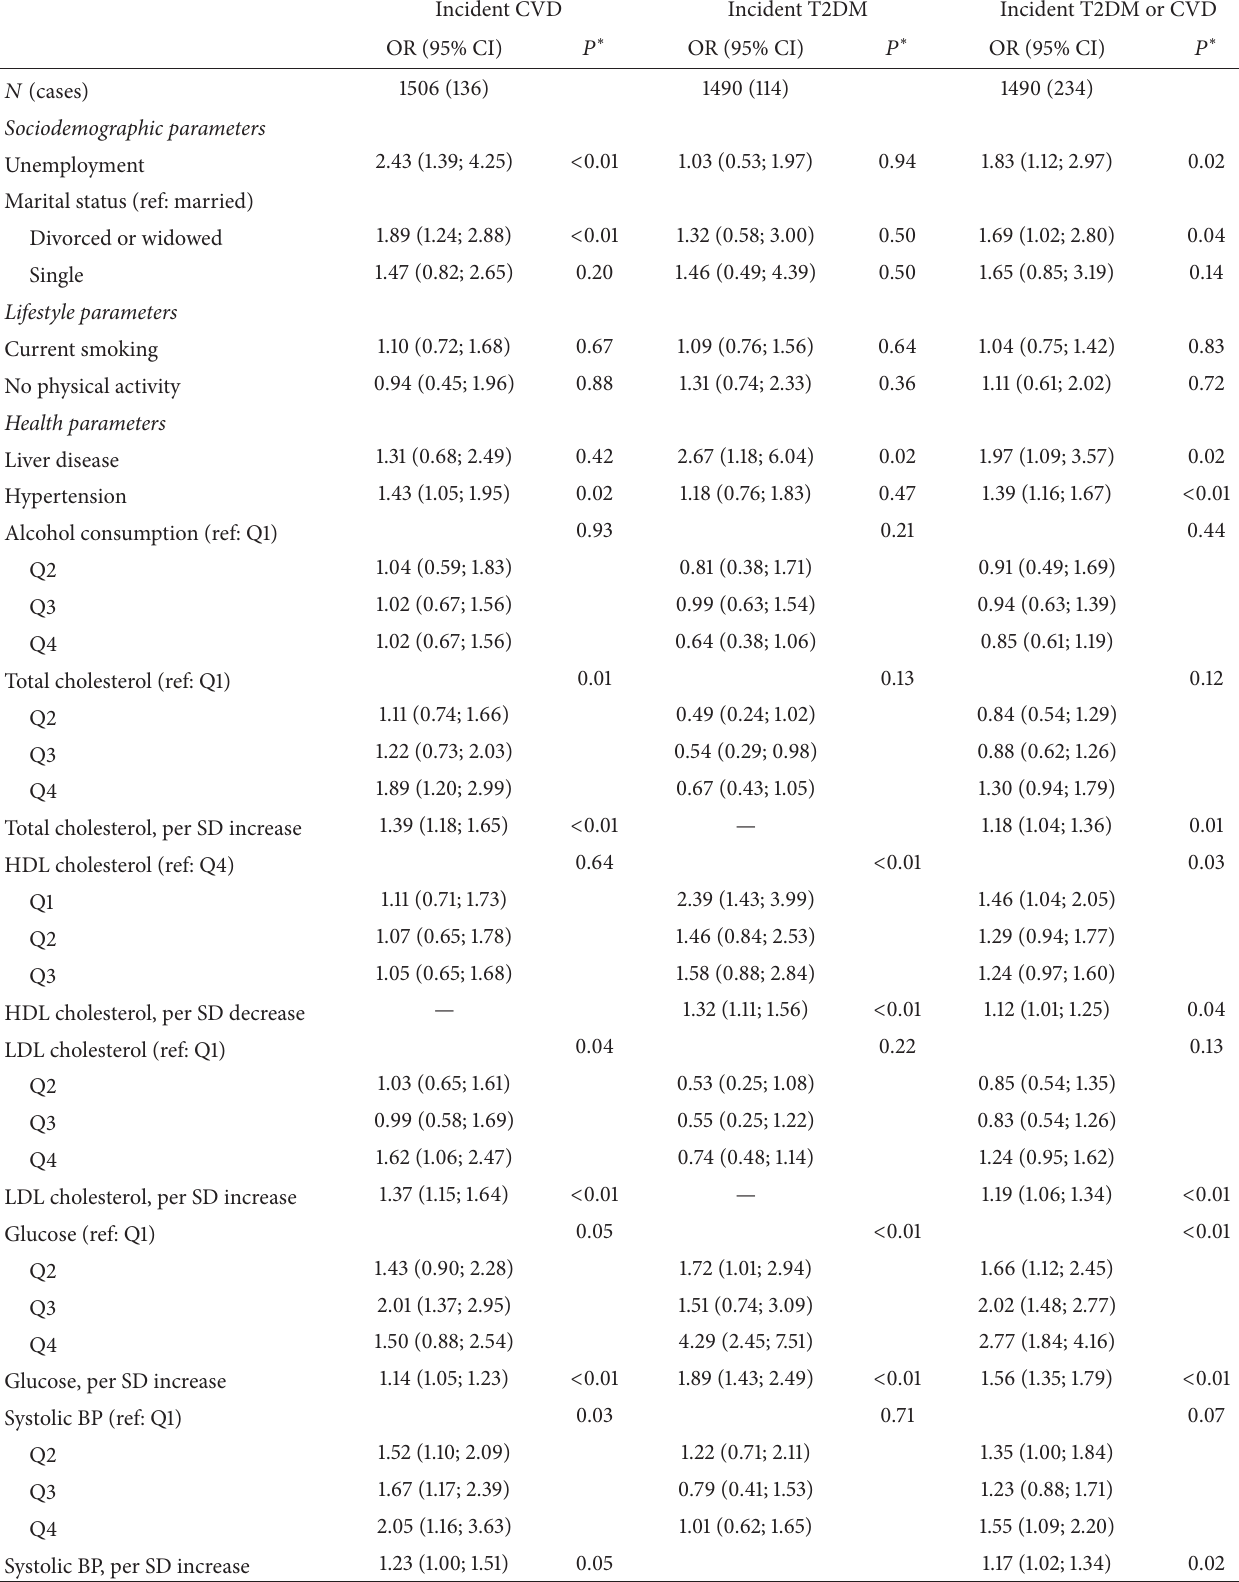
Table 2: Association between potential predictors and cardiovascular disease (CVD) or type 2 diabetes mellitus (T2DM) among abdominal obese individuals calculated by logistic regression models adjusted for sex, age, and waist